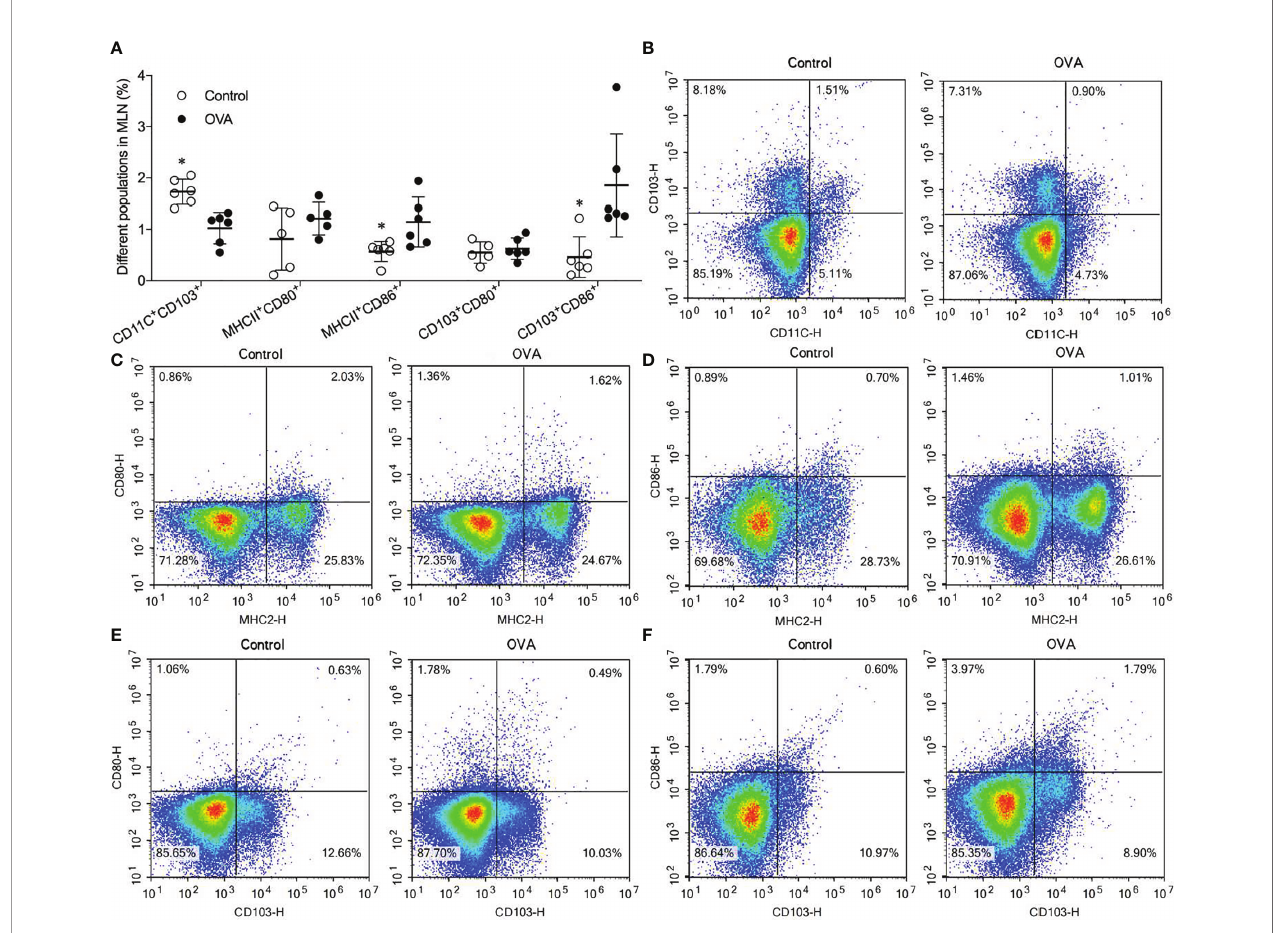
FIGURE 4 | Levels of CD11 + CD103 + DC, MHCII + CD80 + DC, MHCII + CD86 + DC, CD103 + CD80 + DC, and CD103 + CD86 + DC populations in the MLN of different treated mice. The bars in dot plot (A) indicate the percentages of fi ve DCs populations with Mean + SD (n=6/group). The graph (B – F) appeals to the fl ow cytometry density maps of fi ve DCs subsets in MLN of mice. * p ≤ 0.05 vs OVA-treated group; Statistical analyses were performed with two-tailed Student ’ s